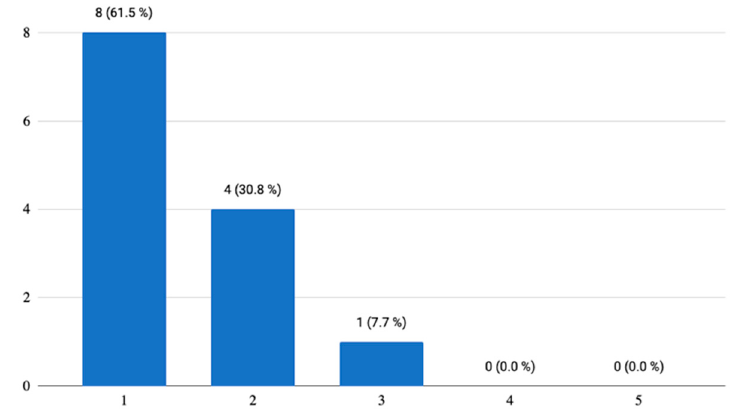
Figure 9. Overall evaluation of the learning modules, tasks and tests.